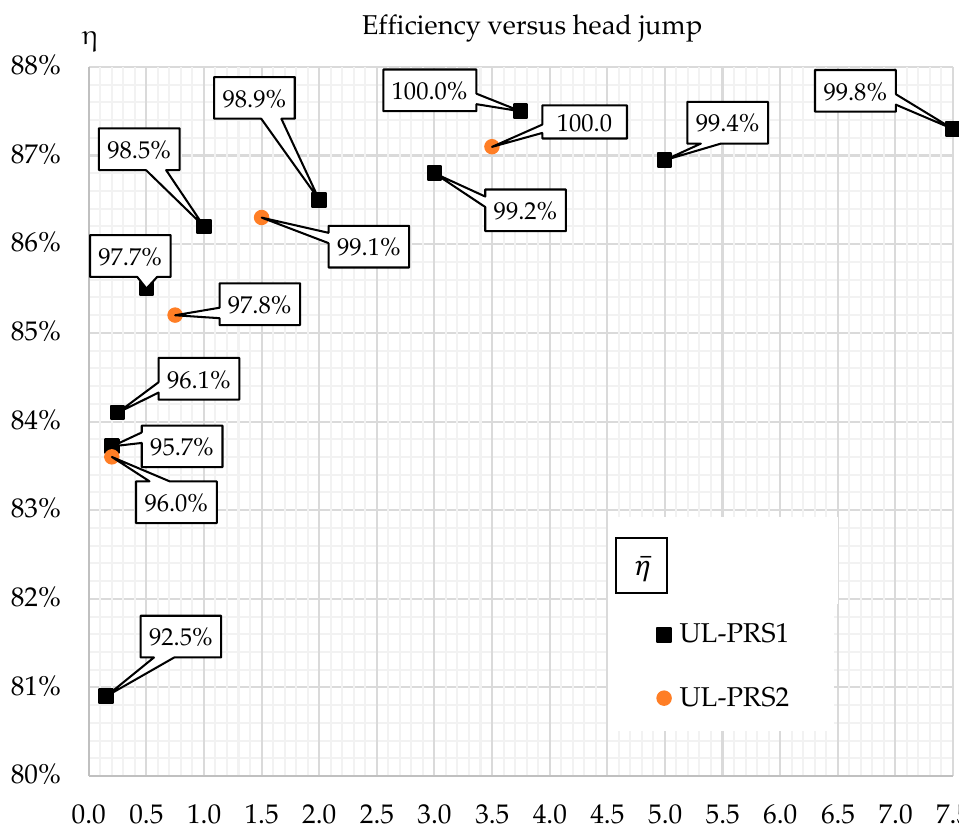
Figure 10. Sensitivity analysis of UL-PRS efficiency with respect to head jump.